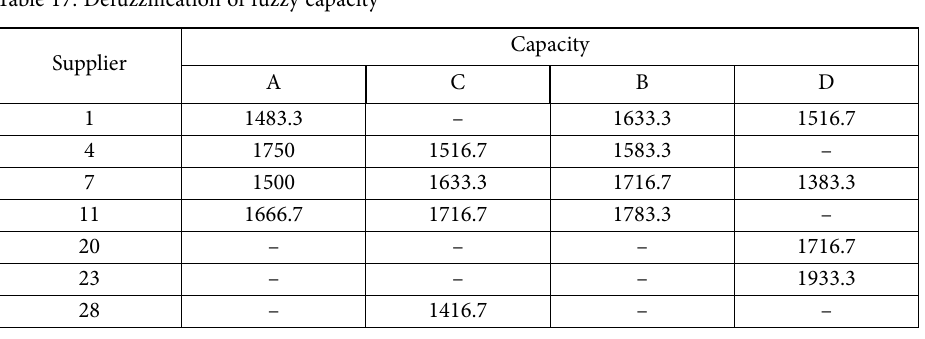
Table 17. Defuzzification of fuzzy capacity